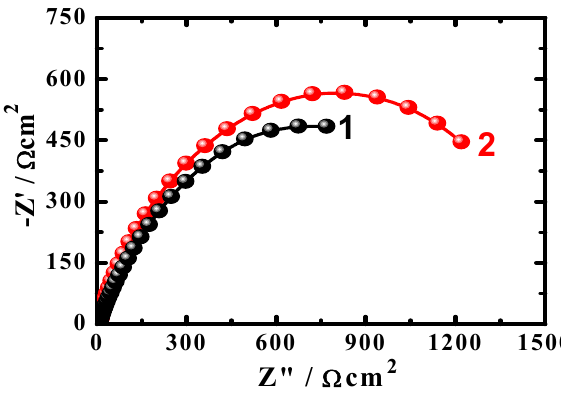
Figure 5. Typical Nyquist obtained for the cast iron electrode after ( 1 ) 1 h and ( 2 ) 24 h immersion in the AGS solution,